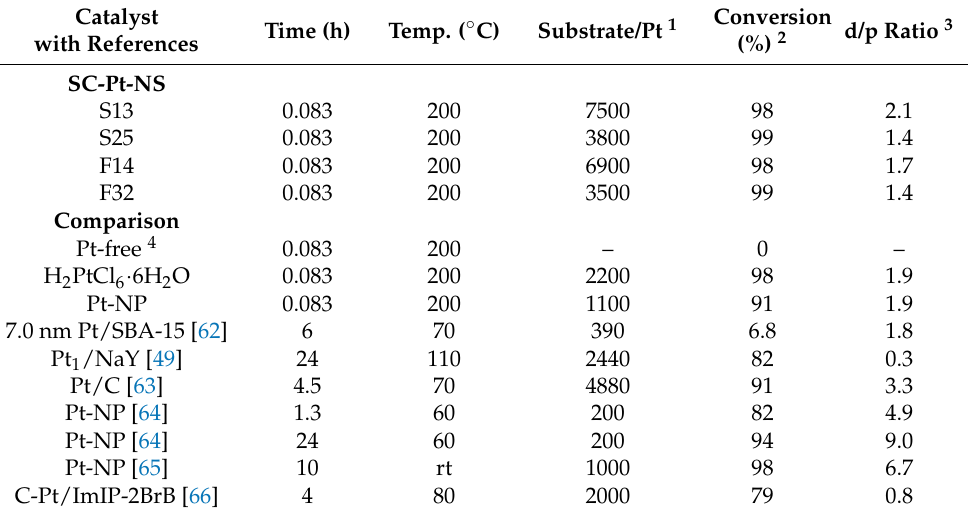
Table 1. Reaction conditions, conversion and distal/proximal ratio of the hydrosilylation of pheny- lacetylene with